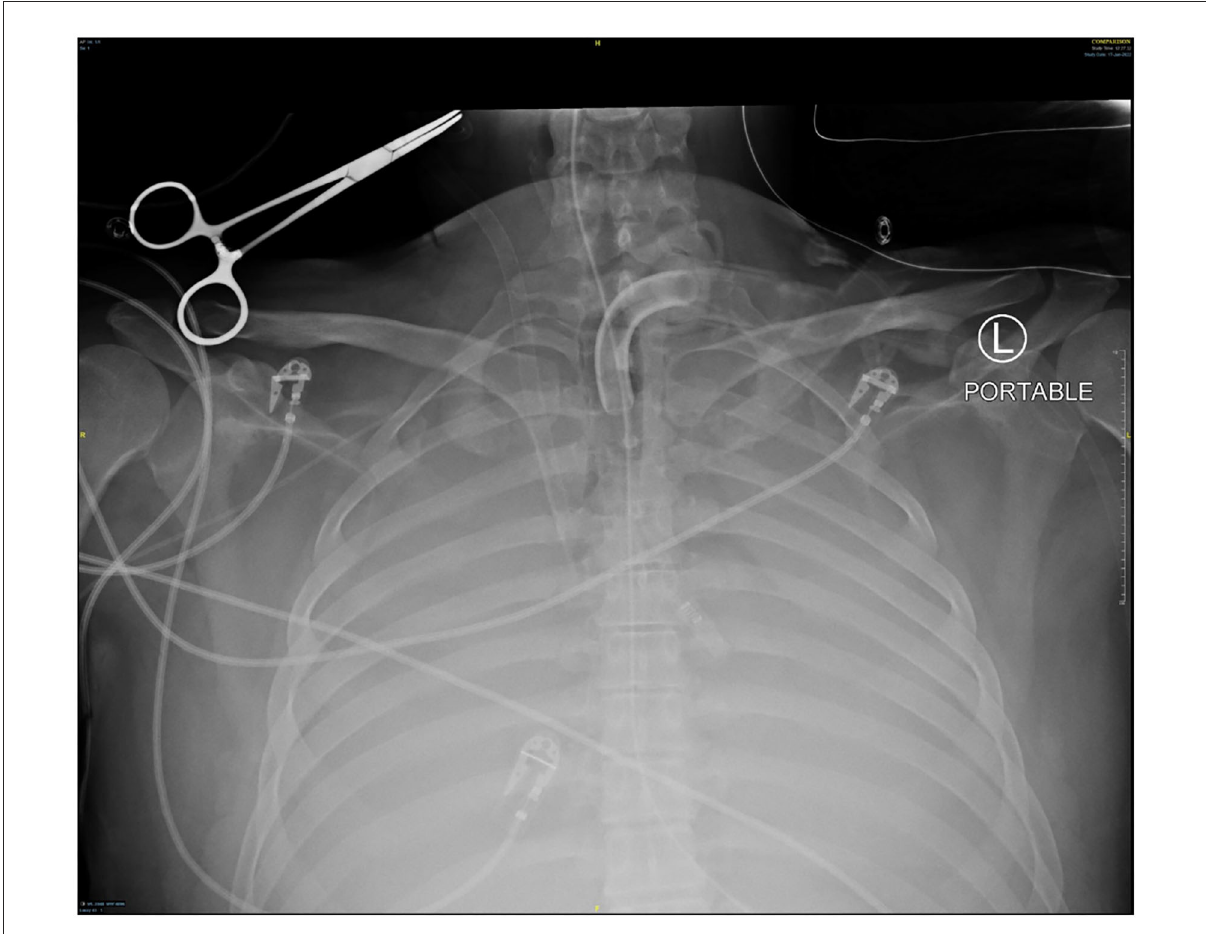
FIGURE4 Chest x-ray off ventilator